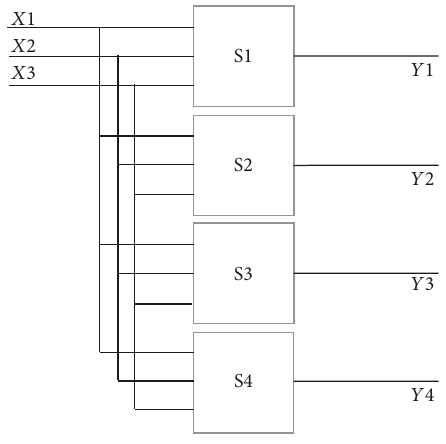
Figure 1: Multi TP model transformation.